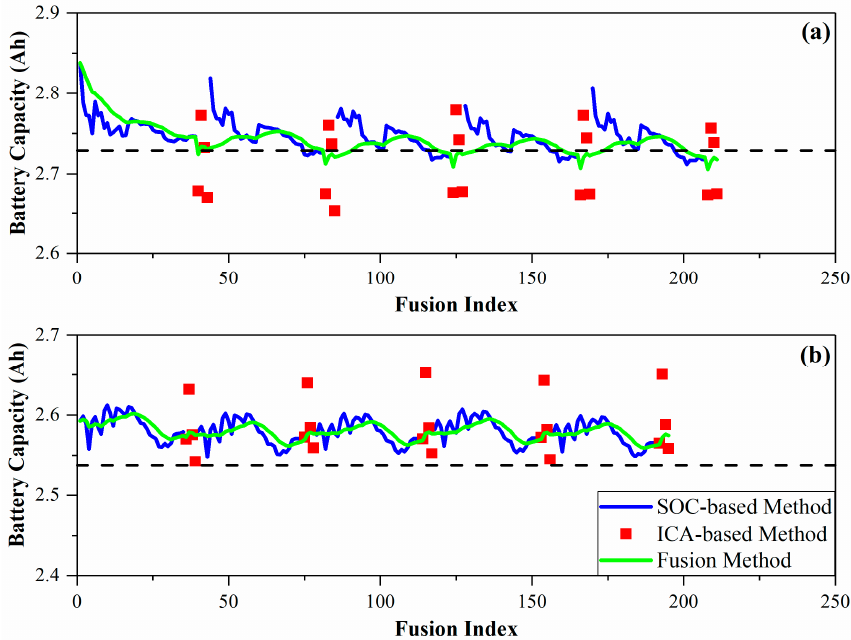
Figure 6. The estimation and fusion results of different cells. ( a , b ) are the results of Cell 2 and Cell 3.